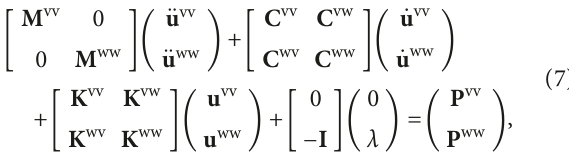
(Figure 2(a)) and u ww � u v